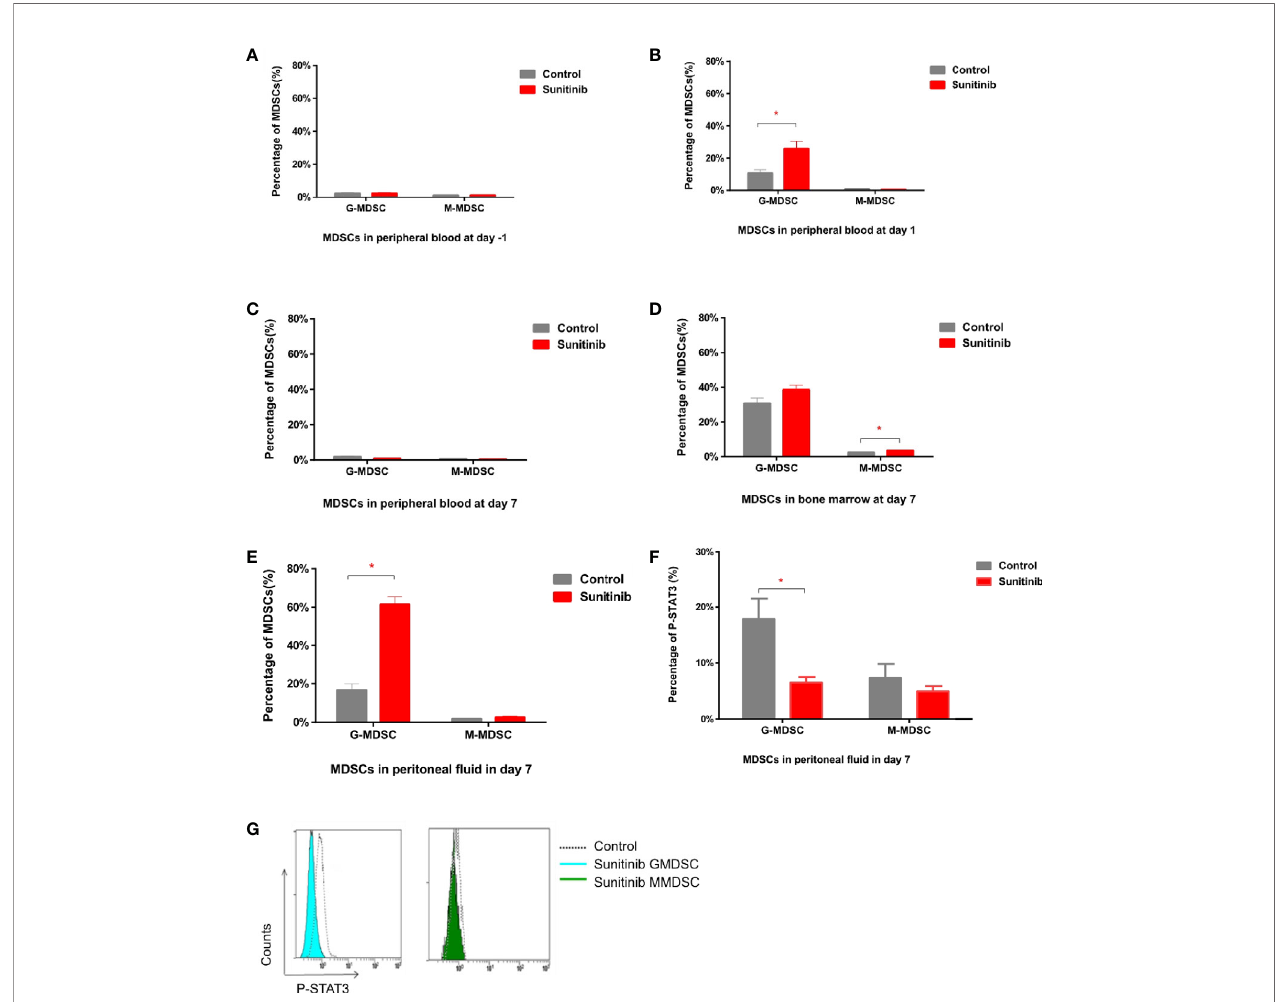
FIGURE 2 | MDSC subsets in peritoneal blood, bone marrow, and peripheral fl uid after Sunitinib treatment. (A – C) G-MDSC (de fi ned as CD11b + Ly6G + Ly6C lo ) and M-MDSC (de fi ned as CD11b + Ly6G - Ly6C hi ) percentage in peripheral blood 1 day before as baseline (day -1), after 1 day (day 1) and 7 days (day 7) of control and Sunitinib treatment. (D, E) G-MDSC and M-MDSC percentage in the bone marrow and peritoneal fl uid after 7 days of treatment. (F) Percentage of P-STAT3 in peritoneal G-MDSC and M-MDSC after 7 days of treatment. (G) Representative fl ow cytometric analyses of intracellular levels of p-Stat3 in peritoneal MDSCs. Data are expressed as the mean ± SEM from 5 animals in each group, *p <